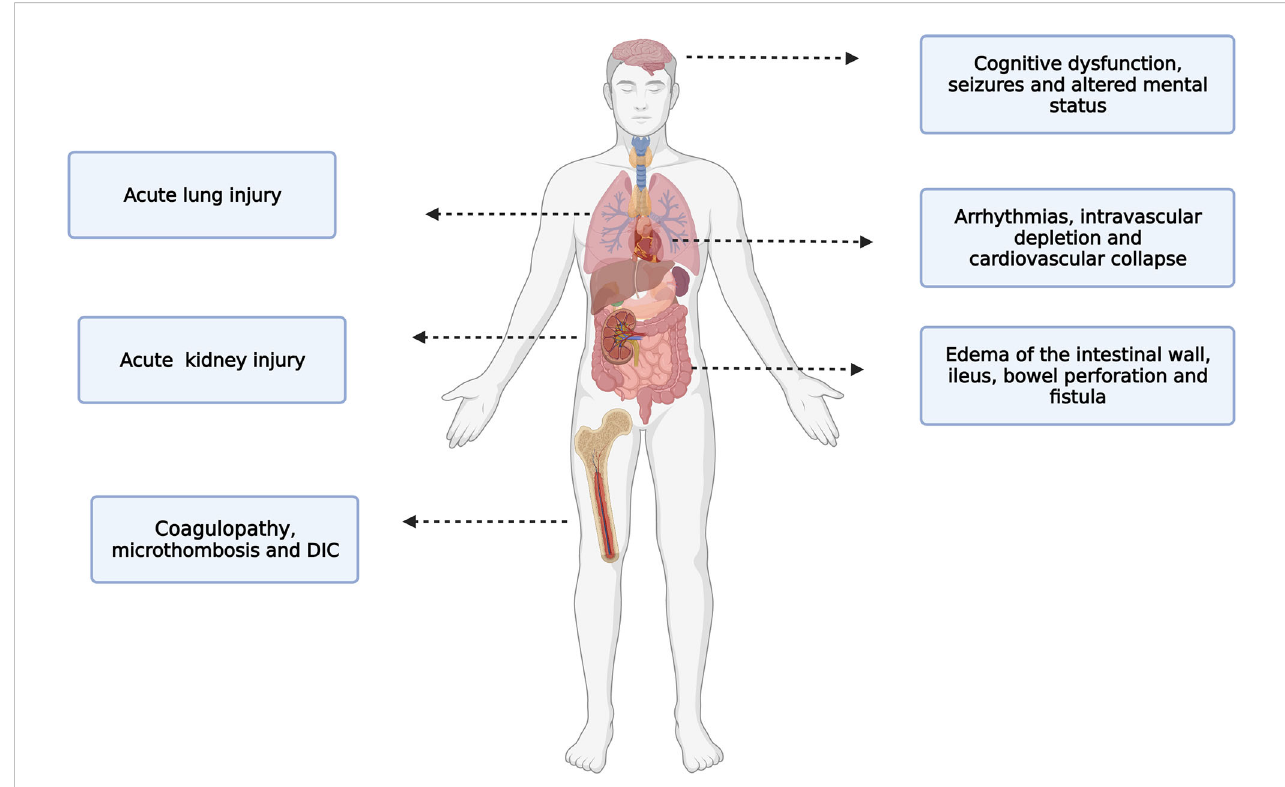
FIGURE 3 Side effects of hyperthermia. Side effects of hyperthermia during